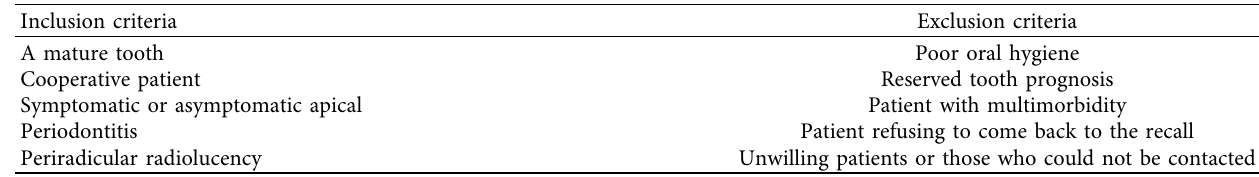
Table 1: Inclusion and exclusion